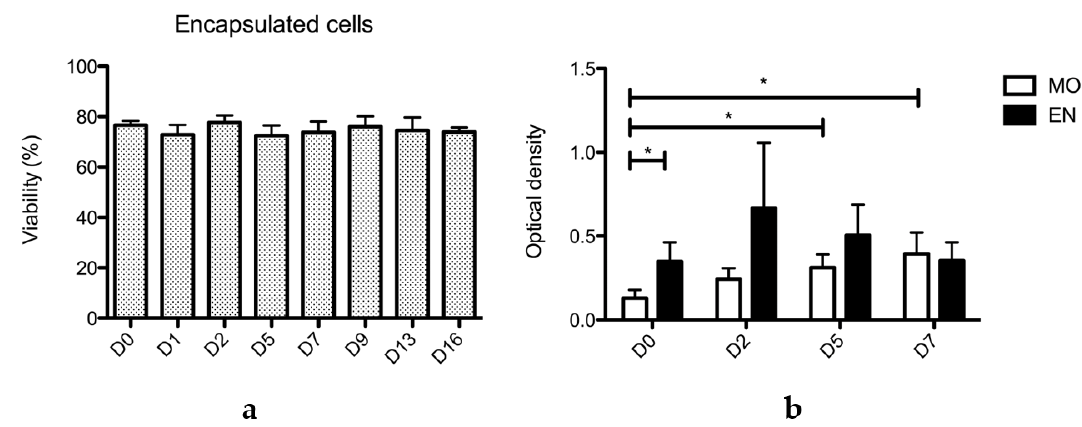
Figure 2. Viability and proliferation of encapsulated and monolayer ASCs from the three donors (16,023 at P3 and P4, 16,198 and 16,148 at P3, n = 4). ( a ) Viability of encapsulated ASCs numerated after Trypan blue coloration from the day of encapsulation (D0) until 16 days after encapsulation (D16) on 500- µ L aliquots. Viability of encapsulated cells remains unchanged for 16 days. ( b ) MTT assays performed on ASCs from the three donors grown as monolayers (MO) and encapsulated (EN). Assays were performed on D0, D2, D5, and D7 after encapsulation. Comparison of the optical density shows a significative di ff erence between D0 and D5 and D0 and D7 for MO cells, a sign of both proliferation and an increase of metabolic activity. Comparison of the two conditions (MO and EN) shows a significative di ff erence only at D0. Statistical significance was assessed with the Mann and Whitney test. *: p < 0.05.